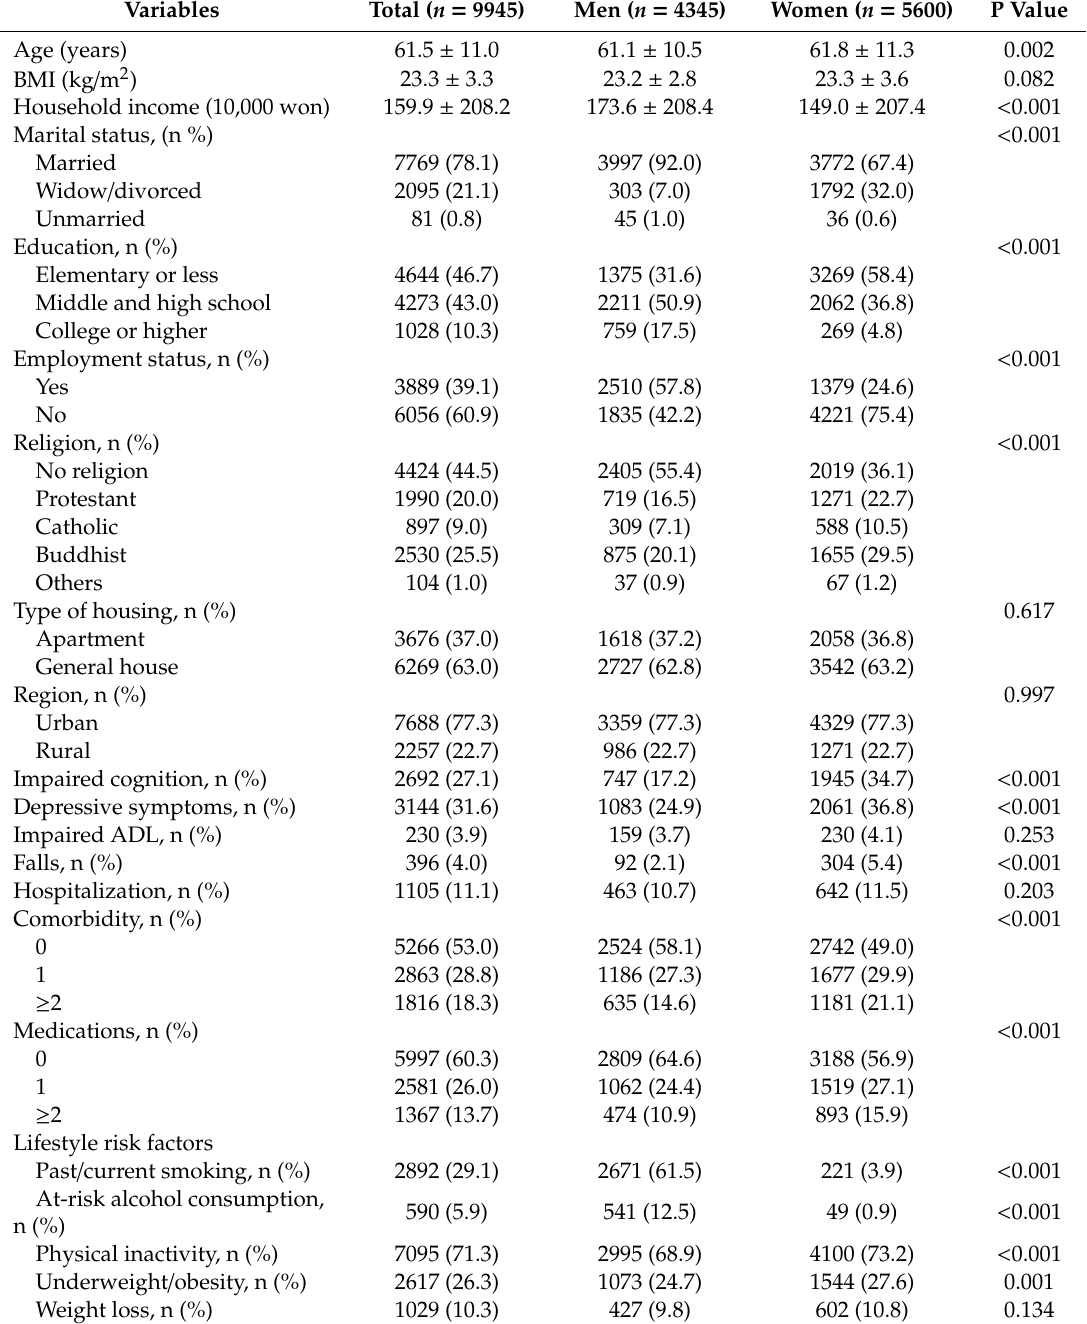
BMI: body mass index, ADL: activities of daily